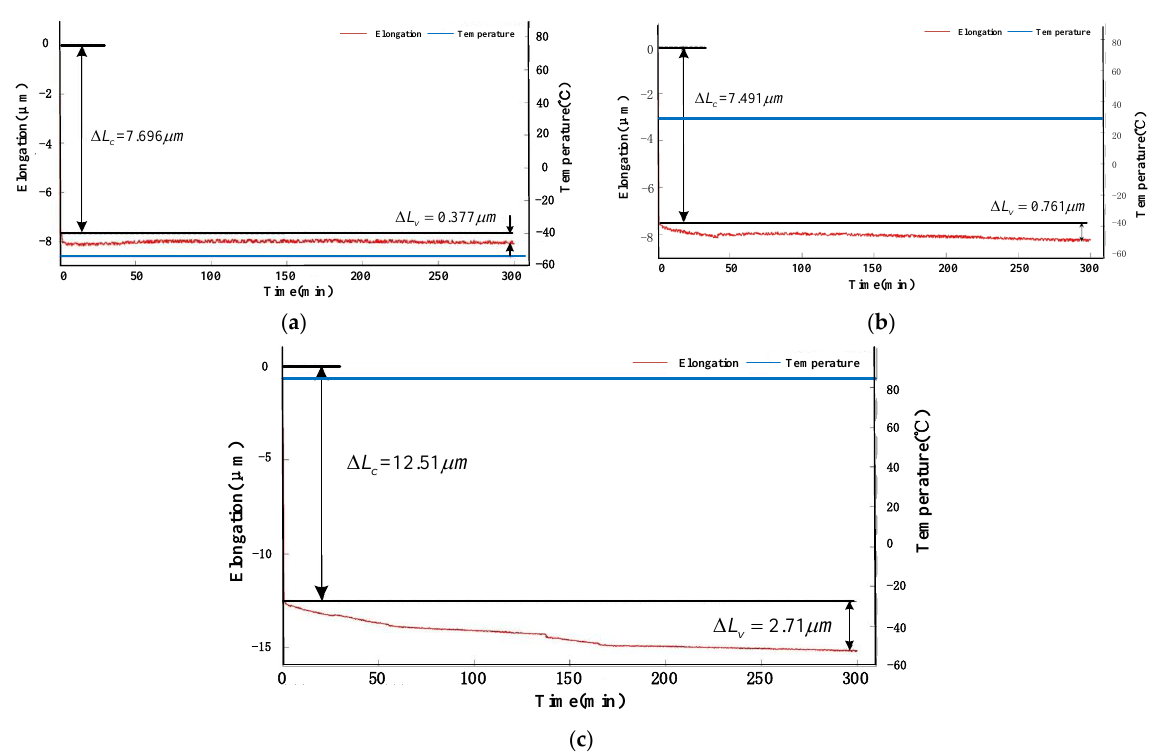
Figure 3. ( a ) is the elongation of ER at − 55 ◦ C; ( b ) is the elongation of ER at − 35 ◦ C; ( c ) is the elongation of ER at − 85 ◦ C. The blue curve represents temperature and the red curve represents the elongation of ER. Figure 3a shows that ER shrank 7.696 μm when it deformed severely, then it shrank